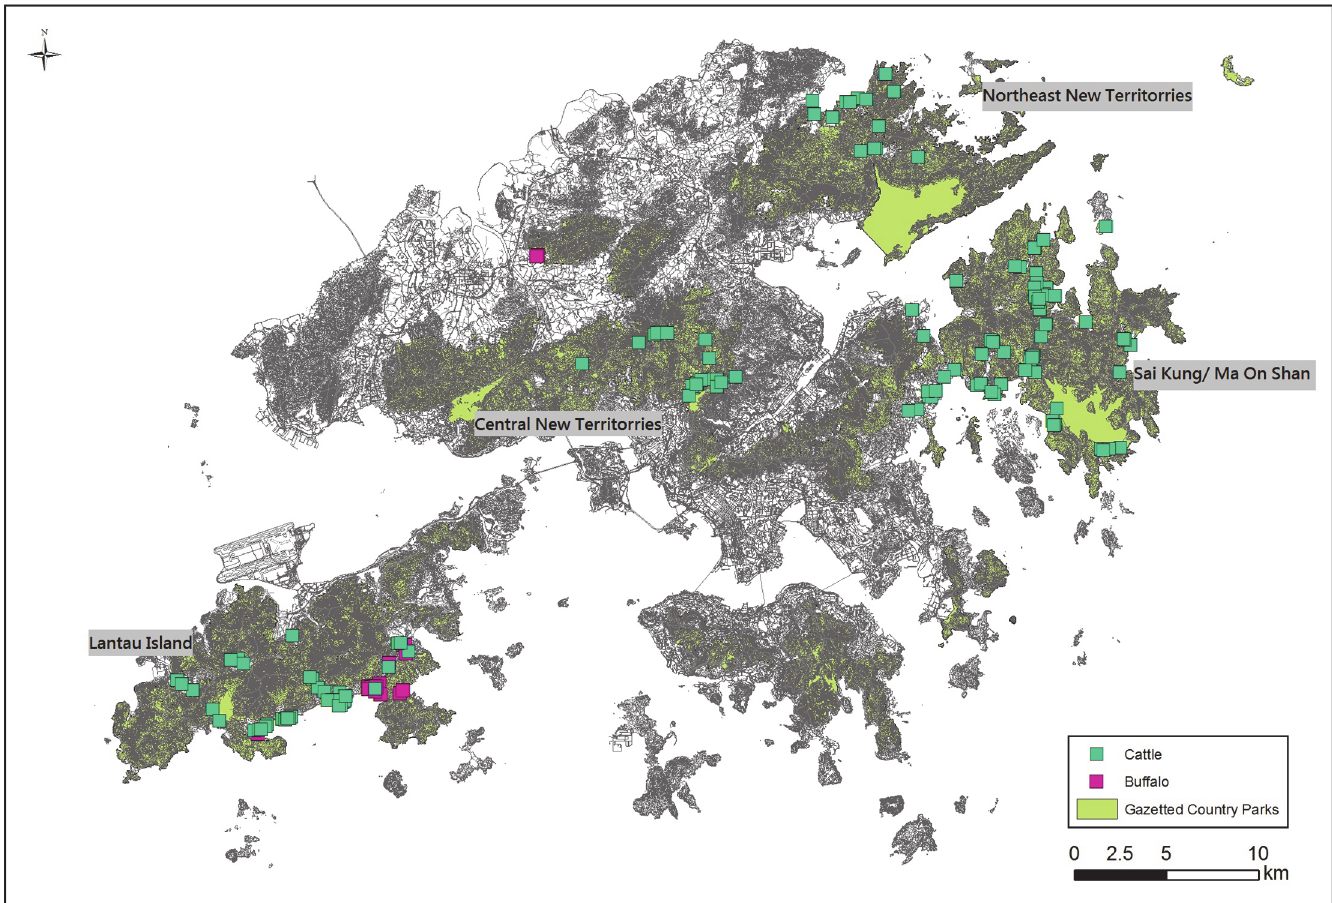
Fig 1. Location of the main populations of feral cattle (green square symbols) in Hong